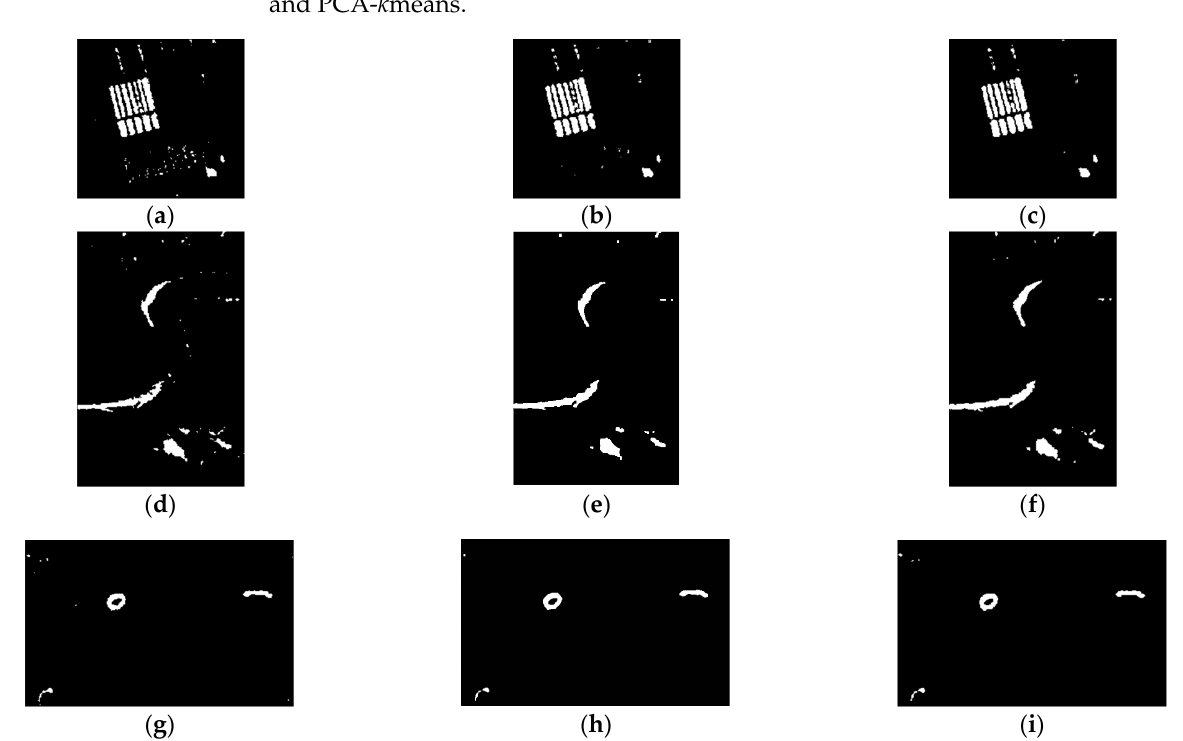
Figure 5. Change detection maps obtained by using different sizes of image patch in three SAR data sets. Farmland data set: